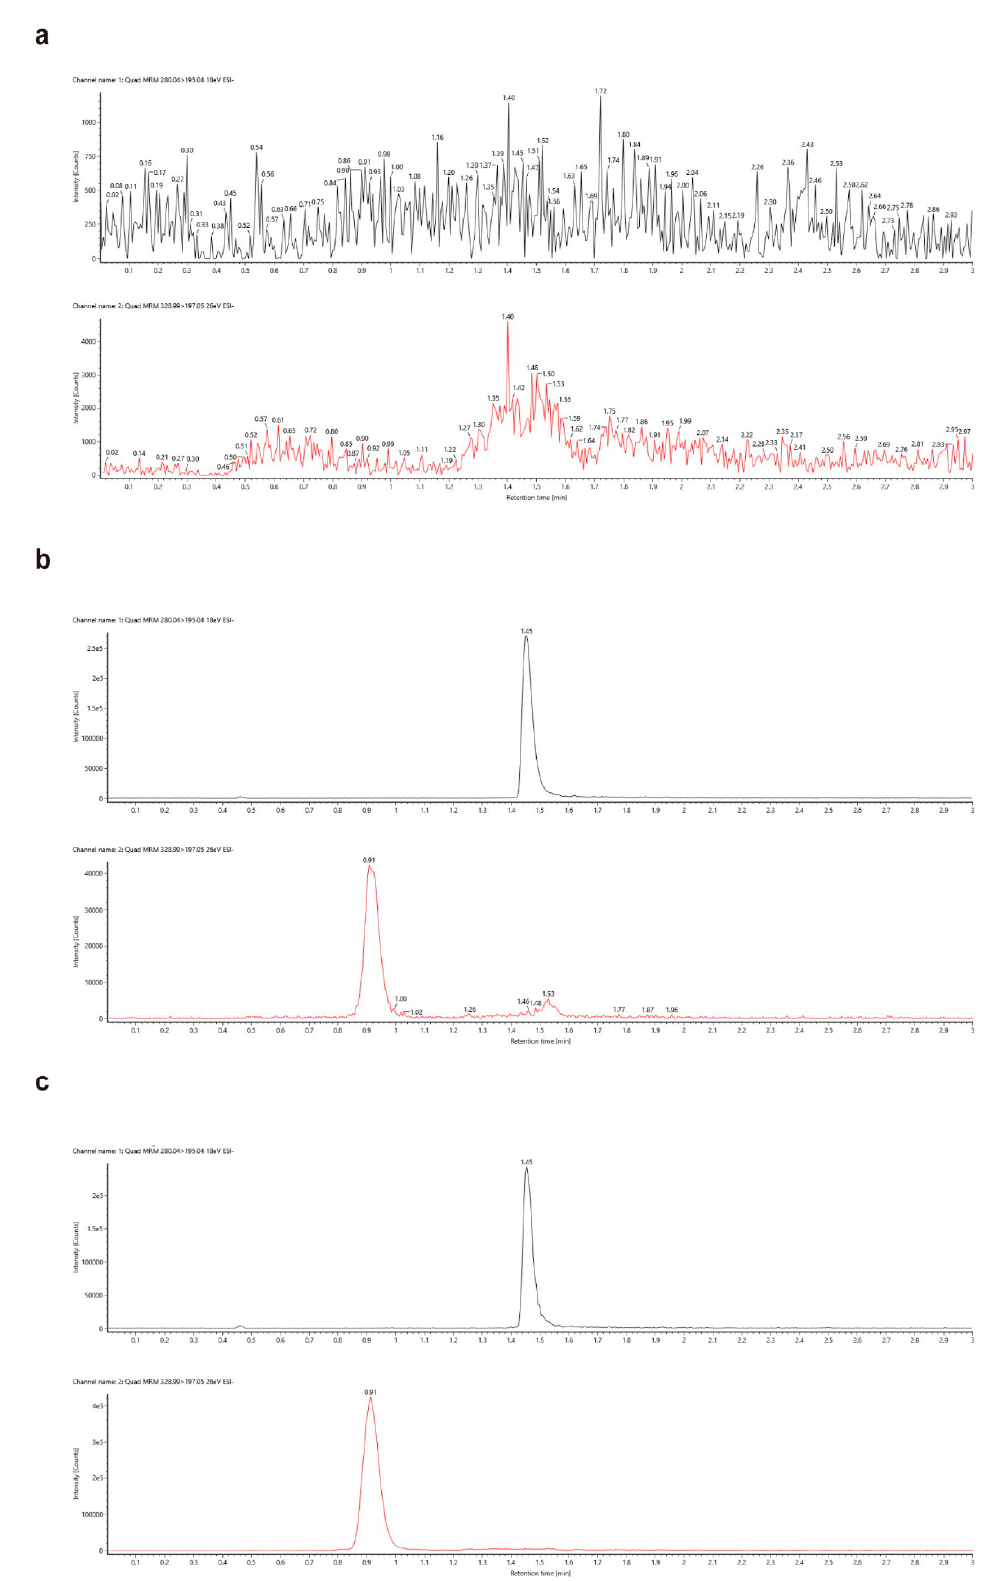
Figure 2. Chromatograms of IS and PQQ in rat blank plasma ( a ), spiked plasma at LLOQ ( b ) and rat plasma samples after oral administration of PQQ disodium salt ( c